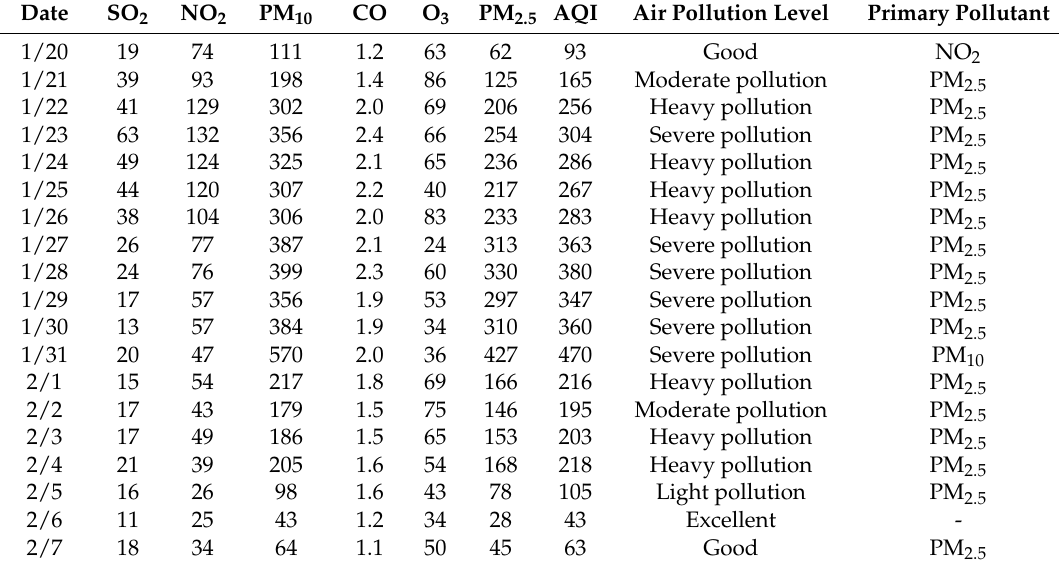
Table 1. Daily AQI and daily mass concentrations for PM 2.5 ( µ g m − 3 ), PM 10 ( µ g m − 3 ), SO 2 ( µ g m − 3